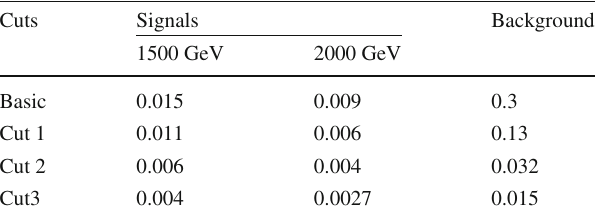
Table 1 Cut flow of the cross sections (in fb) for the signals and SM background at the 3 TeV CLIC with g ∗ = 0 . 3 and two typical VLQ- B quark masses Cuts Signals